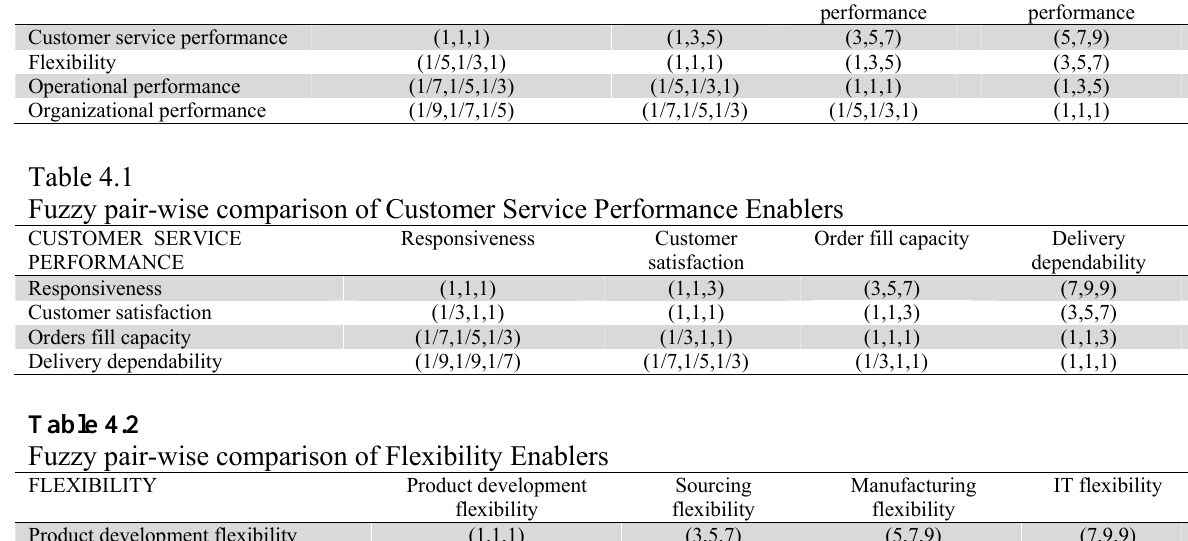
Fuzzy pair-wise comparison of performance indicators Performance Indicators